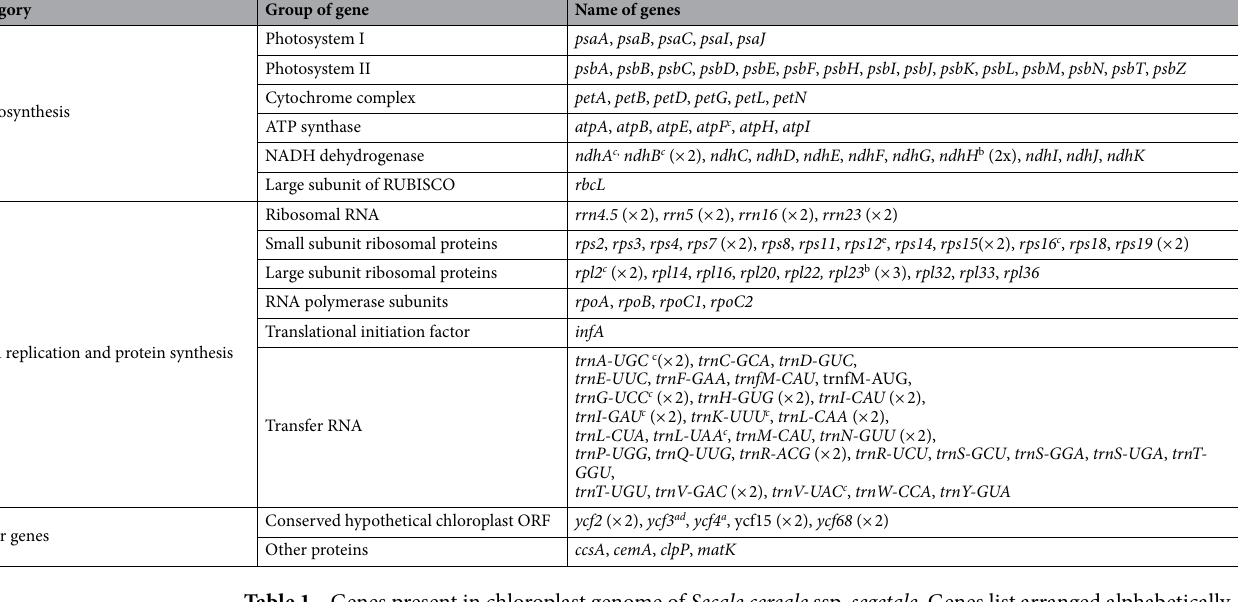
Table 1. Genes present in chloroplast genome of Secale cereale ssp. segetale. Genes list arranged alphabetically. a Genes associated with Photosystem I. b One copy of the gene is a pseudogene. c Gene containing one intron. d Gene containing two introns. e Transspliced